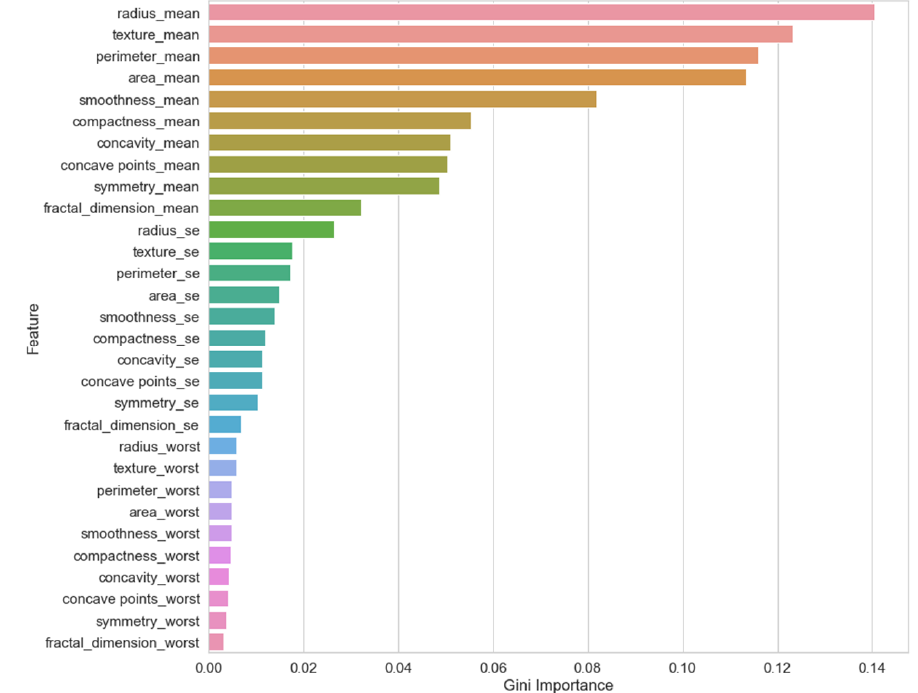
Figure 6. Graphical presentation of feature ranking scores.